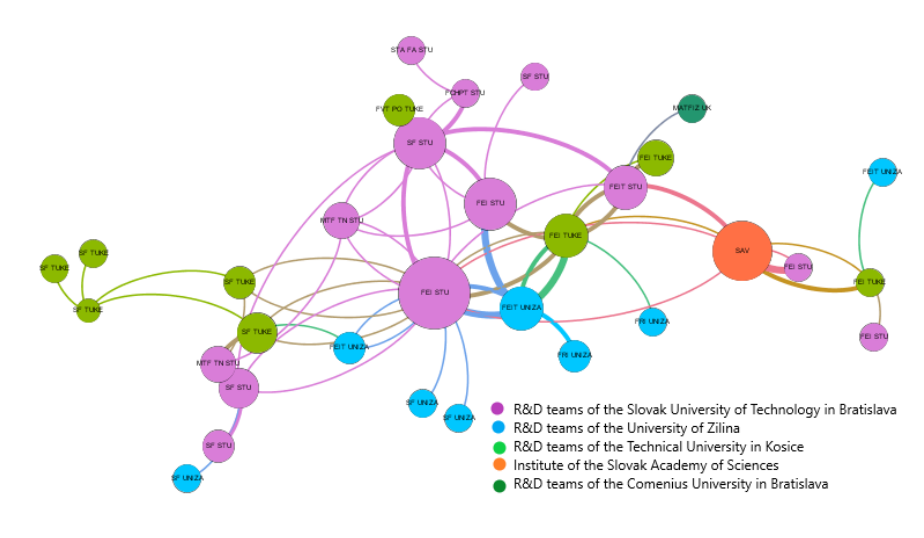
Figure 1. Network of collaborations of domestic R&D teams in Industry 4.0